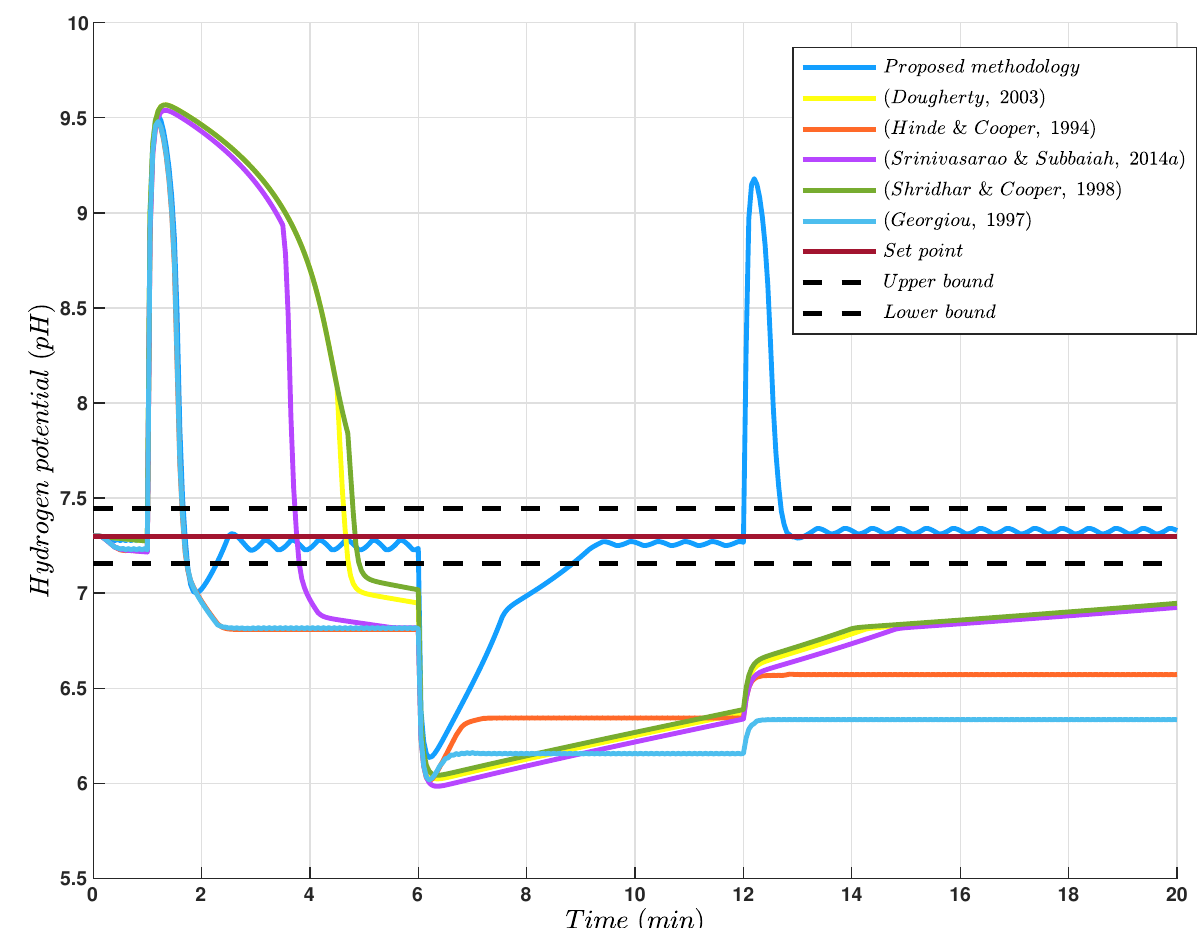
Figure 9. Comparison of the response of NMPC with SIB T-S with CBMD tuned with various proposals case study alkalinization of sugar cane